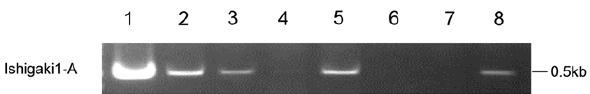
Figure 4. Assay of direct PCR with Biomasher-pellet preparation after fixation. The midribs of Ishigaki1-A Las-infected leaves were divided into equal weight aliquots and fixed with respective fixation chemicals. After fixation, templates for direct PCR were prepared using the Biomasher-pellet method. Amplicons of each PCR were confirmed with 1.5% agarose gel electrophoresis. Templates were as follows: lane 1, Extracted DNA (for conventional PCR); lane 2, Biomasher-pellet without fixation; lane 3, Extracted DNA after Biomasher-pellet (for